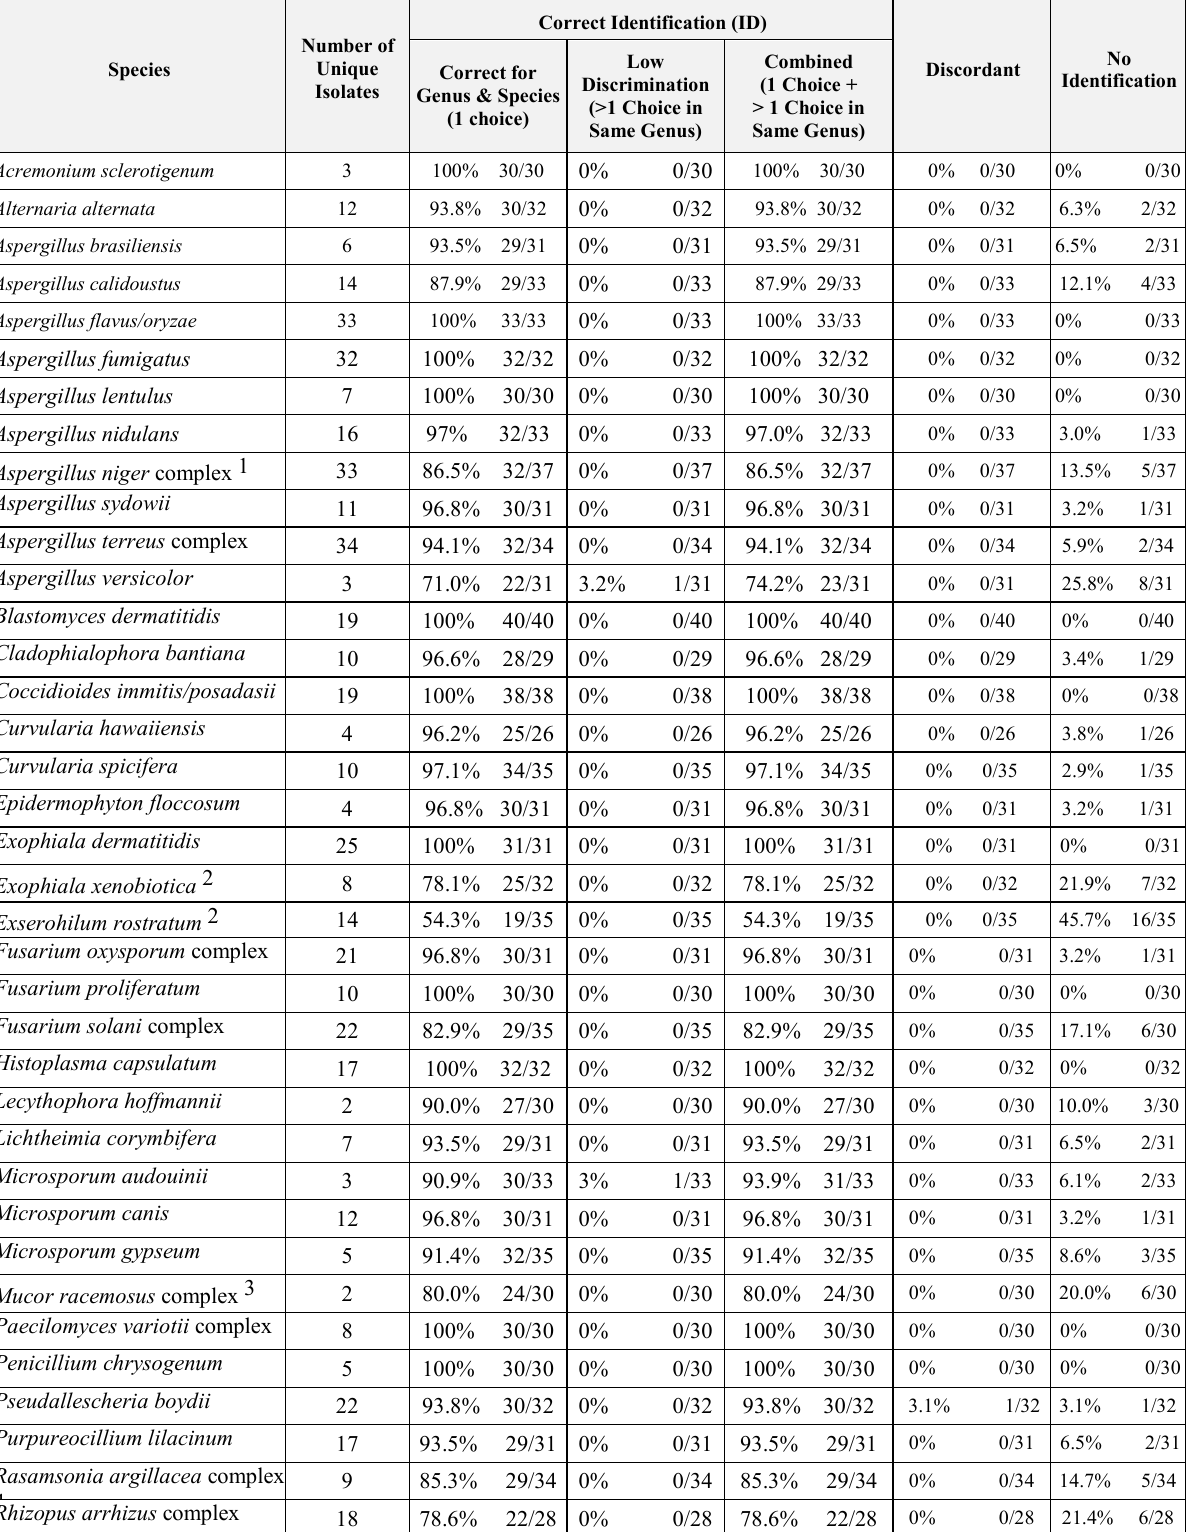
TABLE 13: Mould Performance with VITEK MS V3.0 Knowledge